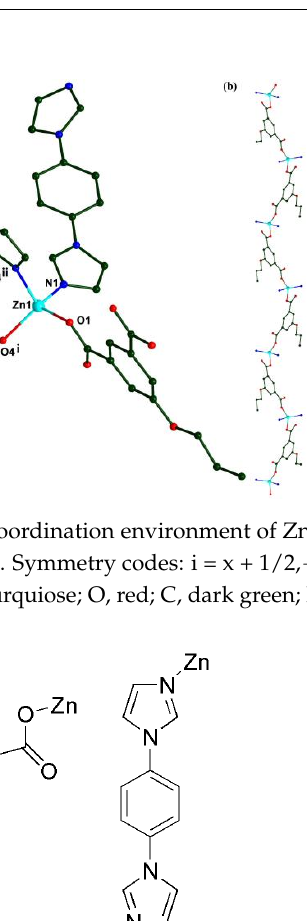
Figure 1. ( a ) The coordination environment of Zn(II) ions in complex 1 . ( b ) View of the 1D zigzag chain of complex 1 . Symmetry codes: i = x + 1/2, − y + 1/2,z + 1/2; ii = − x + 5/2,y − 1/2, − z + 3/2. Color Scheme 1. The coordination modes of 5-PIA and imbm ligands in complex 1 . codes: Zn, turquiose; O, red; C, dark green; N, blue. Figure 2. View of the 3D framework of complex 1 parallel to the a -axis.